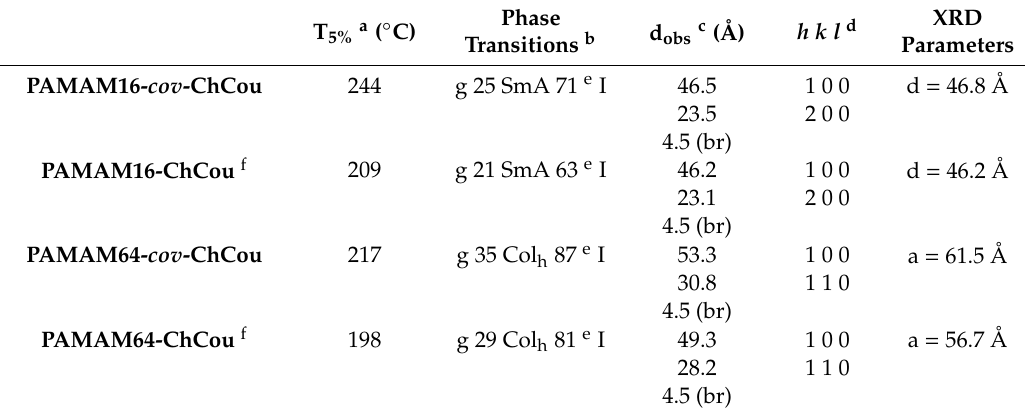
Table 1. Thermal properties and structural